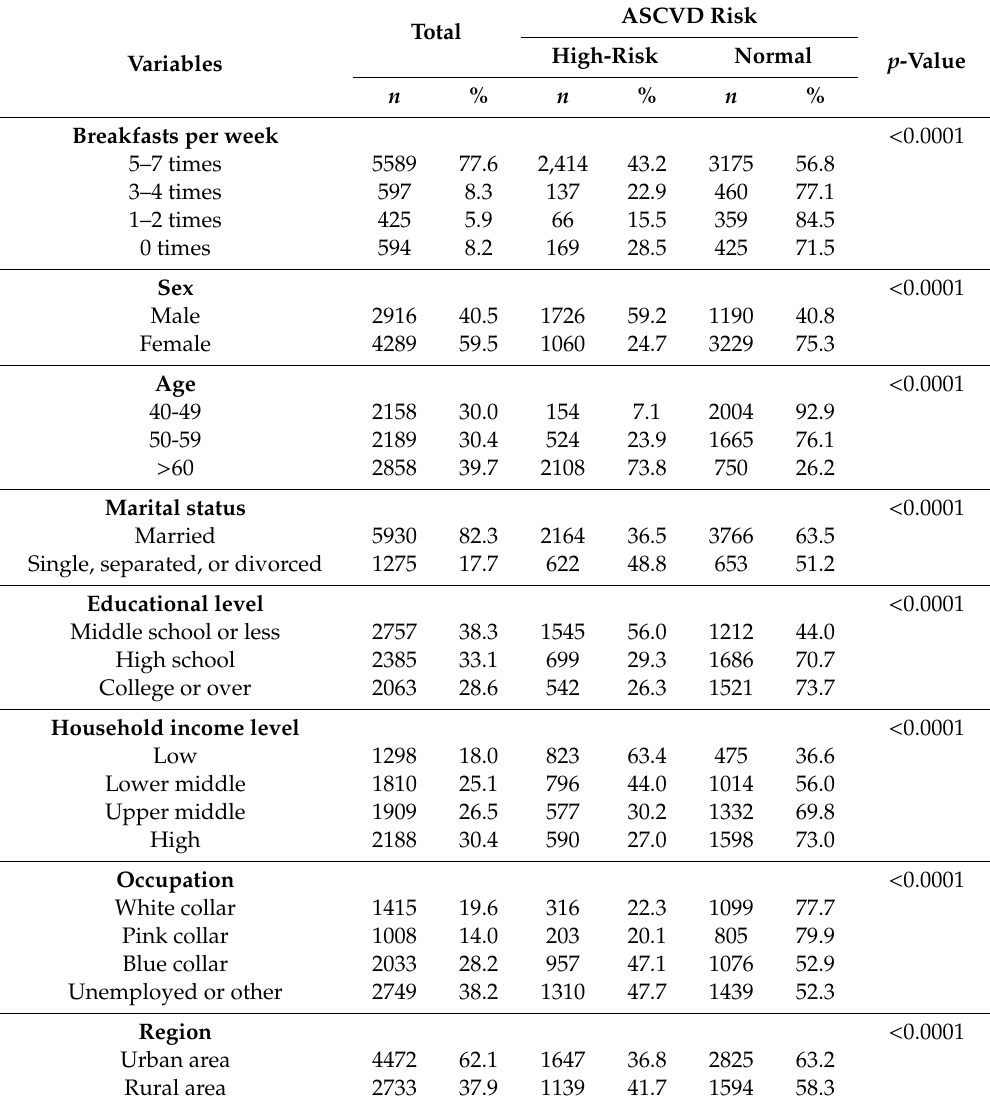
Table 1. General characteristics of the study